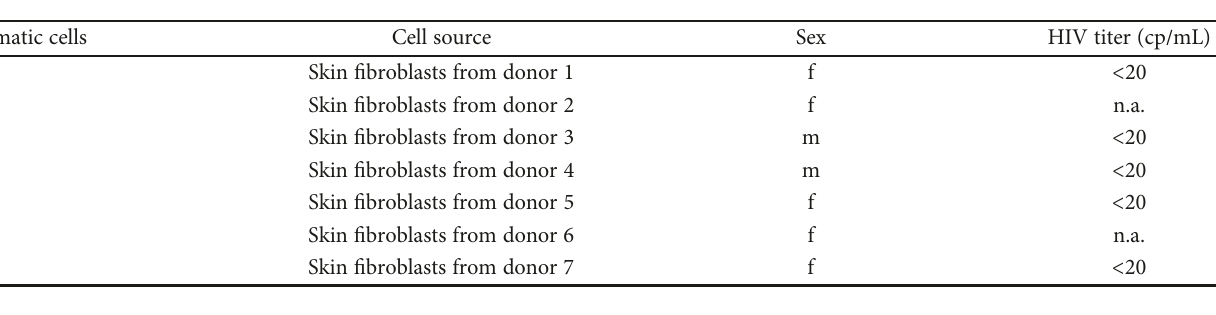
Table 1: Cells/cell lines used in this study for HIV